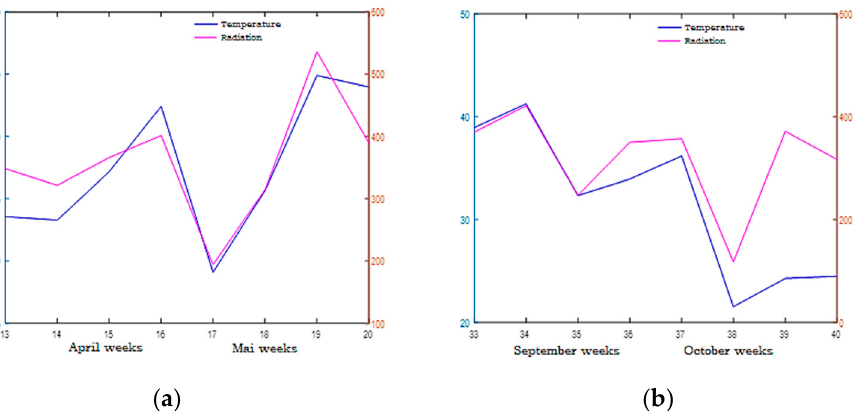
Figure 24. Influence of temperature on solar radiation evolution ( a ) April and May ( b ) September and October.